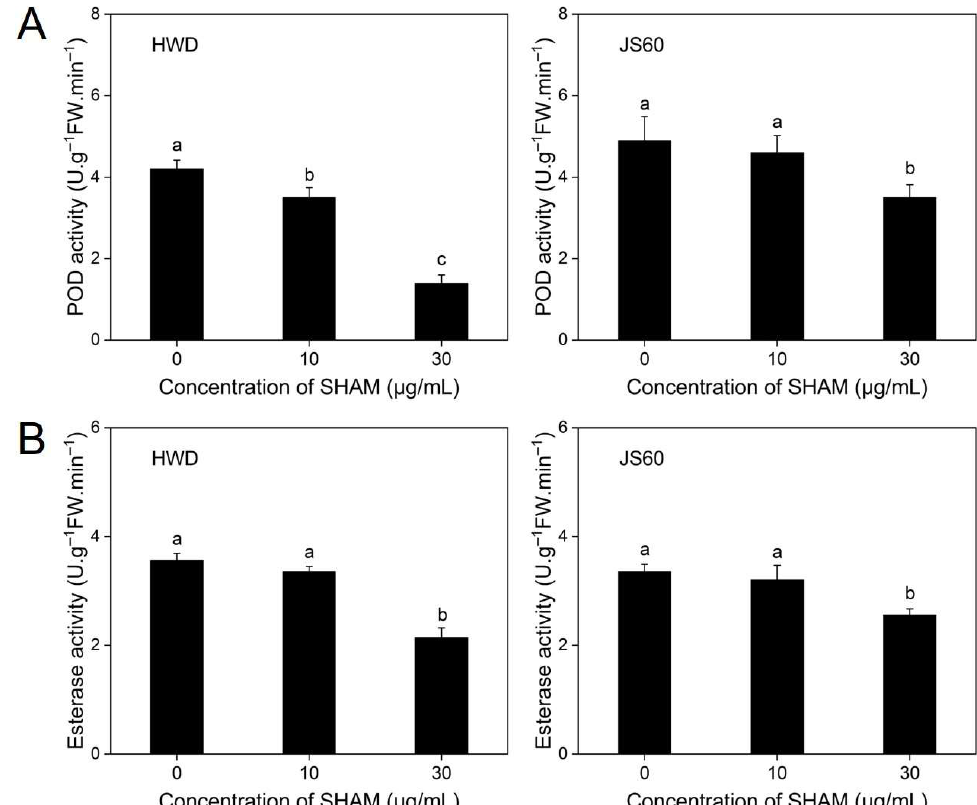
Figure 4. Effects of SHAM on activities of peroxidase (POD) ( A ) and esterase ( B ) of Ustilaginoidea virens isolates HWD and JS60. Error bars represent standard errors of the mean of independent three repetitions. Different letters are significantly different from each other ( p < 0.05) based on one-way analysis of variance (ANOVA) with a least significant difference (LSD) test. Table 3. Effects of SHAM at different concentrations on sensitivity of U. virens to azoxystrobin and